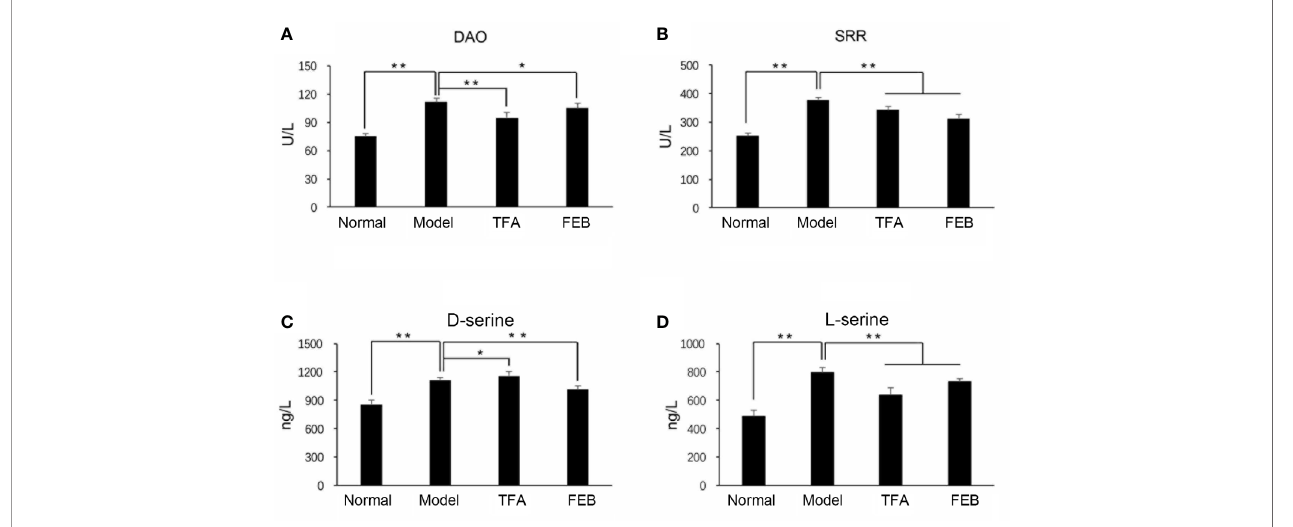
FIGURE 3 | Effects of TFA and FEB on gut-derived metabolites. (A – D) Serum levels of DAO, SRR, D -serine, and L -serine in the Normal, Model, TFA, and FEB rat groups. The data are expressed as the mean ± SD. * P < 0.05, ** P < 0.01. TFA, total fl avones of Abelmoschus manihot ; FEB, febuxostat; DAO, D -amino acid oxidase; SRR, serine racemase; SD, standard